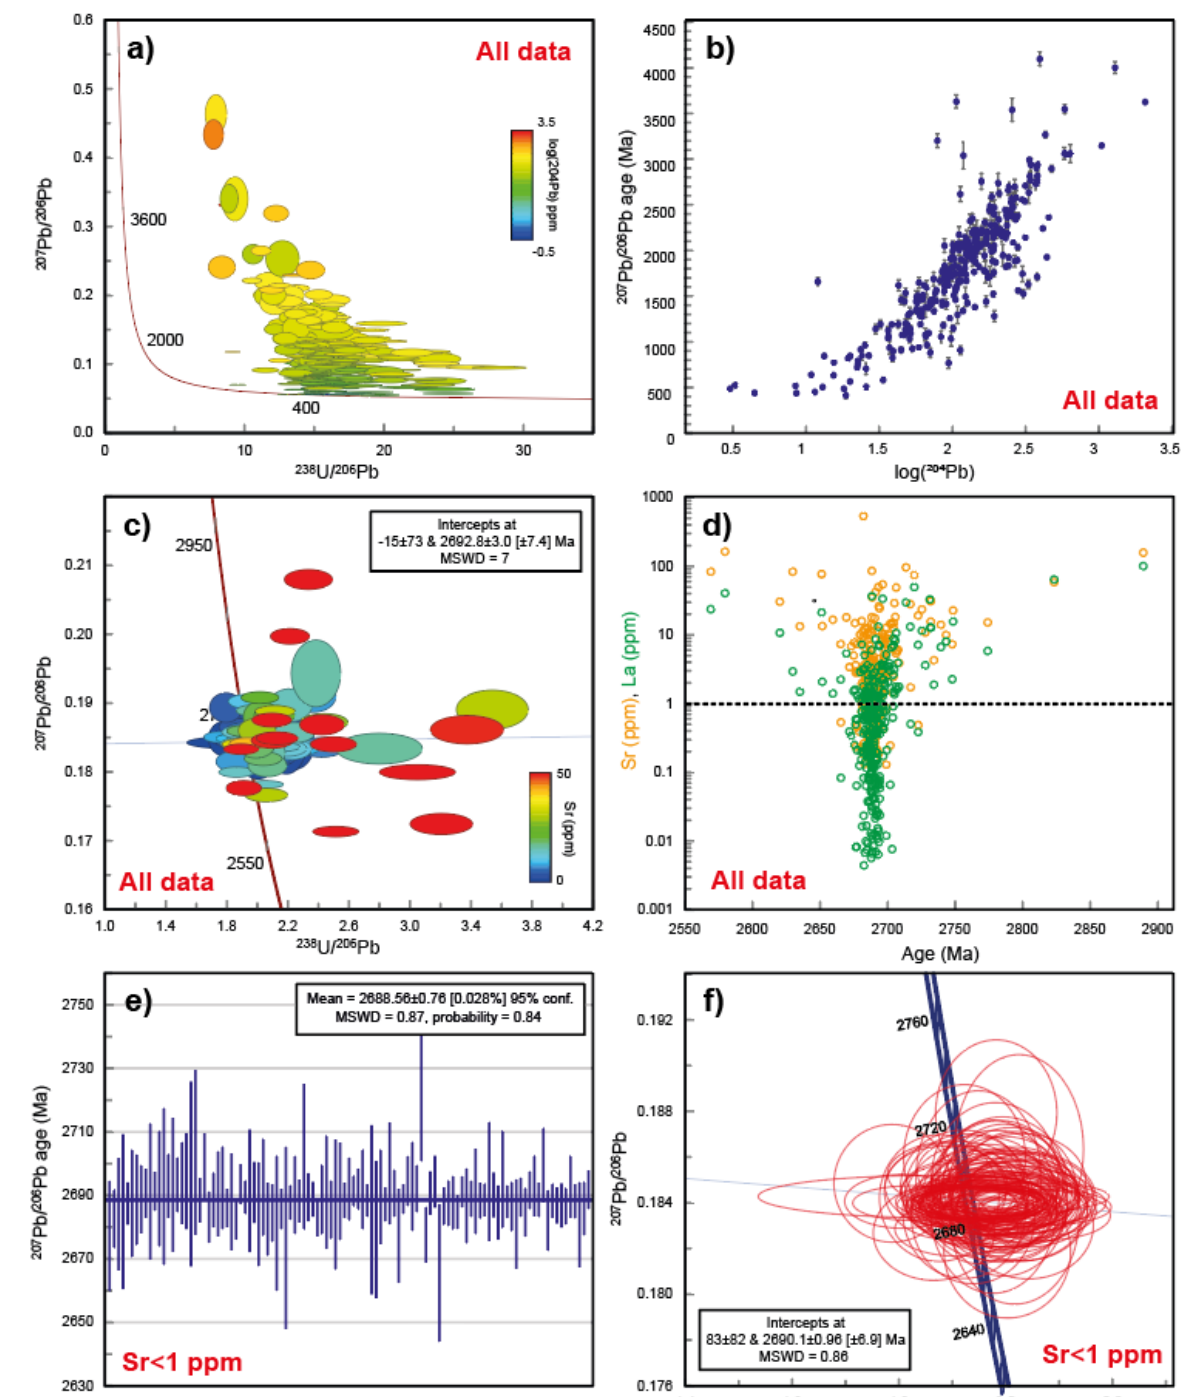
Figure 7. Geochronological results (LA-ICP-MS analyses) for 322 and 292 zircon grains from, respectively, the D1A ( a , b ) and D3 ( c – f ) samples. Ellipses in Concordia diagrams are 2 σ and are colored for 204 Pb ( a ) and Sr ( c ) concentrations. Individual 207 Pb/ 206 Pb data are displayed as a function of 204 Pb for the D1A sample ( b ), and as a function of Sr and La concentrations for the D3 sample ( d ). Zircon U-Pb age spectra ( e ) and Concordia diagram ( f ) showing the data conforming to filter criteria (Sr < 1 ppm) for the D3